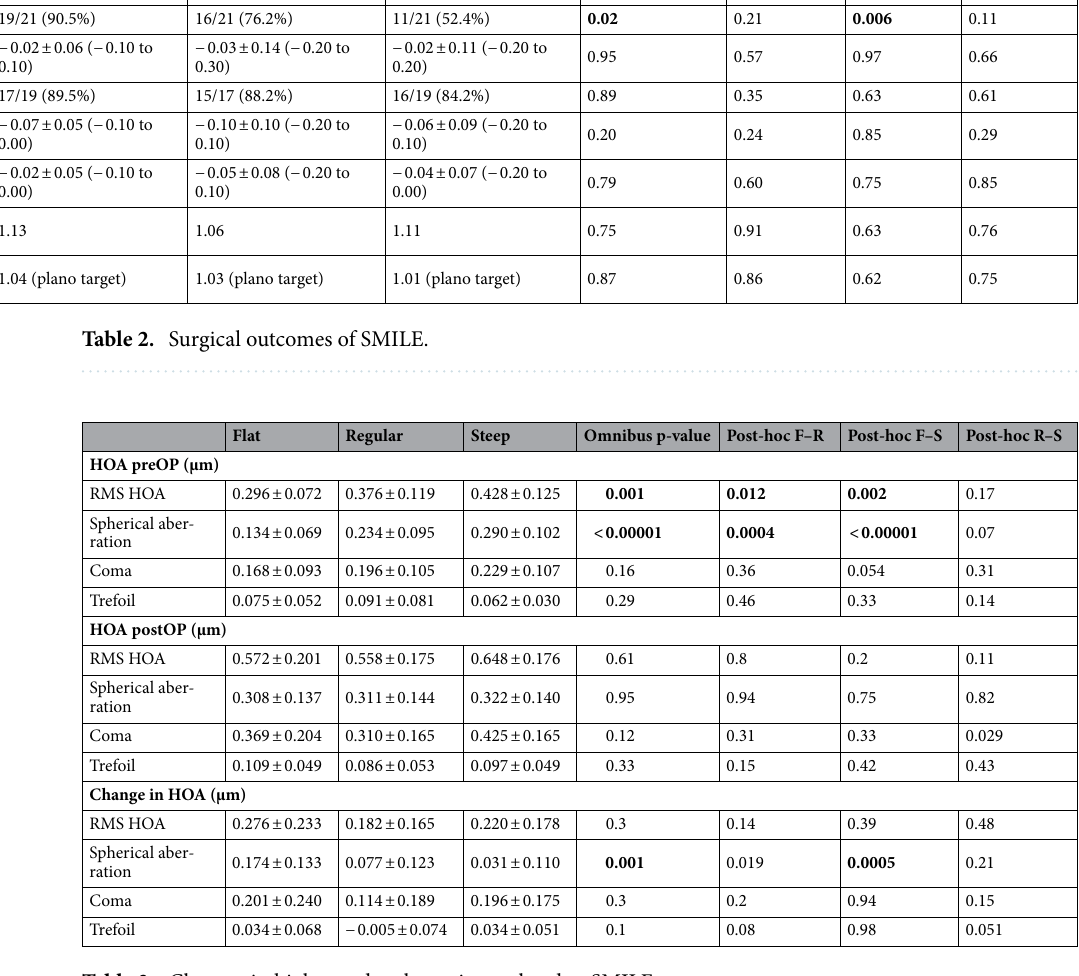
than the two other groups (flat: 0.296 ± 0.072 vs. regular: 0.376 ± 0.119, p = 0.012; vs. steep: 0.428 ± 0.125, p = 0.002; Table 3). This effect seemed to be largely caused by spherical aberration, which also was significantly lower in